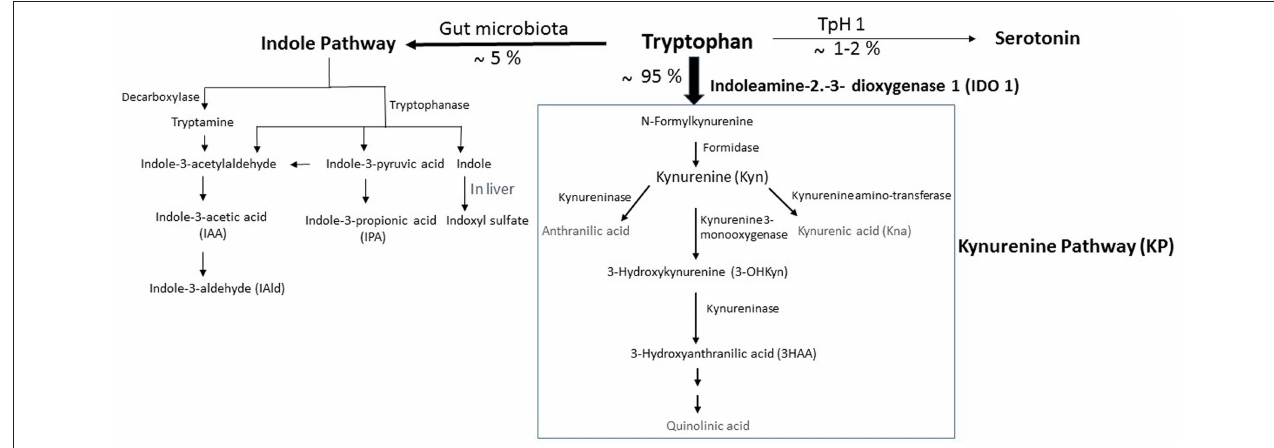
FIGURE 1 | Simplified illustration of the kynurenine pathway in the gastrointestinal tract. Tryptophan (Trp) is predominantly converted into kynurenine (Kyn) pathway (KP) by the indoleamine 2,3-dioxygenase 1 (IDO). A small amount of Trp is converted by gut microbiota through the action of the enzyme tryptophanase, into indole, and its derivatives and into tryptamine. Indole metabolites could be converted in the liver into indoxyl sulfate. Another fraction of Trp is converted through Trp hydroxylase 1 (TpH 1) into